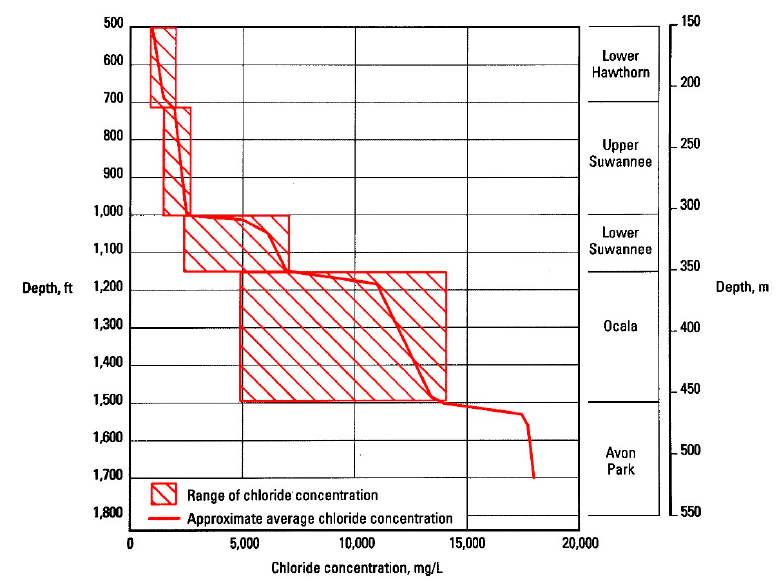
Figure 8. Dissolved chloride profile with depth as used in the original solute transport model for the City of Cape Coral Utility Master Plan (from [12,21]).